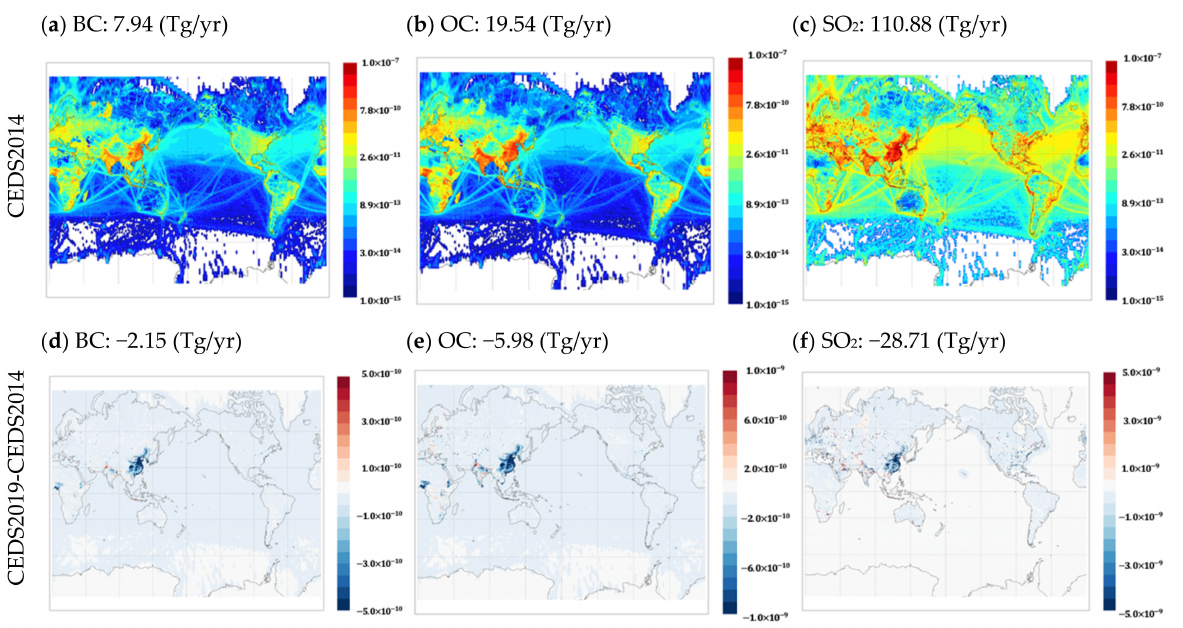
Figure 1. Global distributions of annual average emissions (Gg/m 2 /yr) of BC, OC and SO 2 in CEDS 2014 ( a – c ) and the differences between CEDS 2014 and CEDS 2019 ( d – f ) (the global annual total emissions (Tg/yr) are shown above the figures).